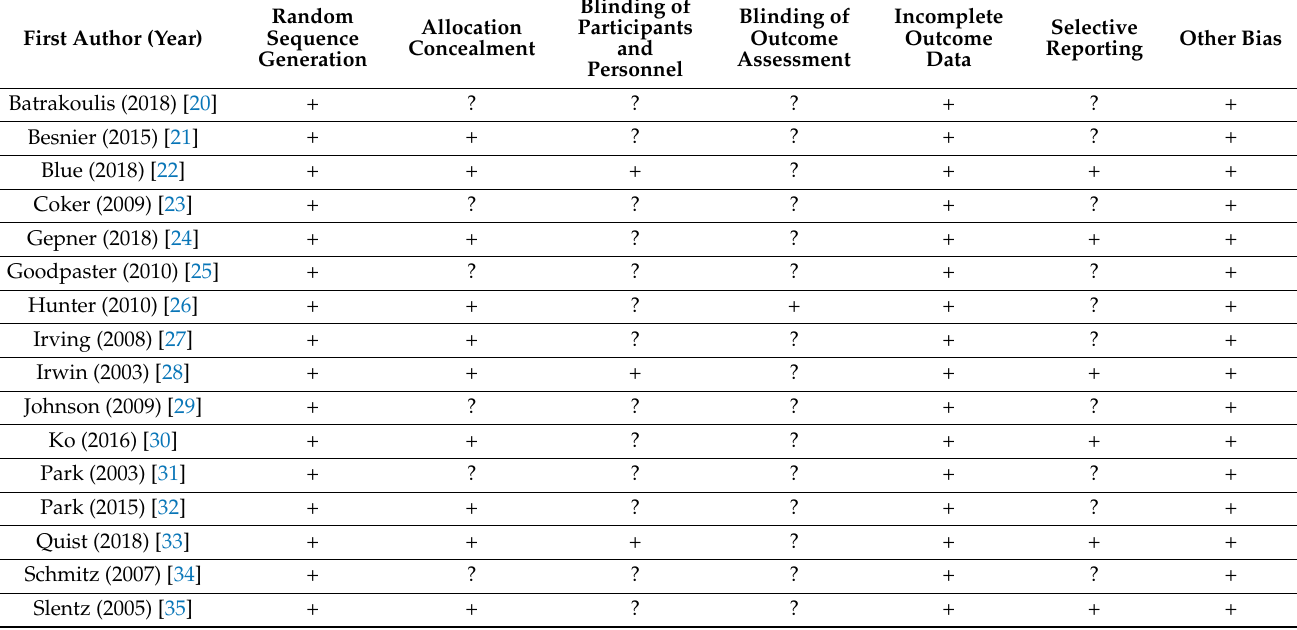
Table 2. Assessments of the Cochrane Collaboration’s Risk of